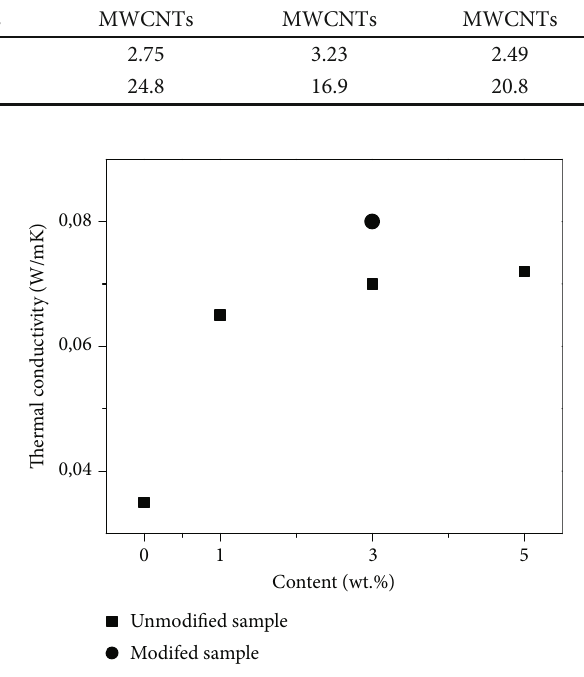
Table 3: Heat absorption ratio and temperature deviation of PU/MWCNT nanocomposites with various MWCNT contents. Properties